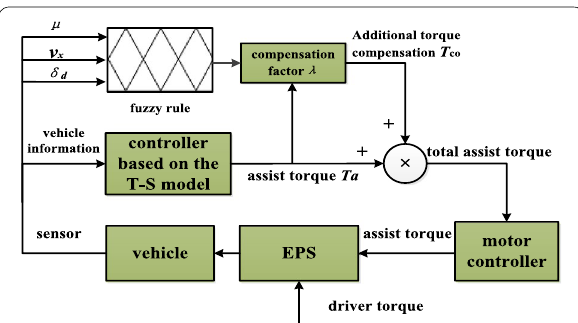
Figure 6 Feedforward compensation